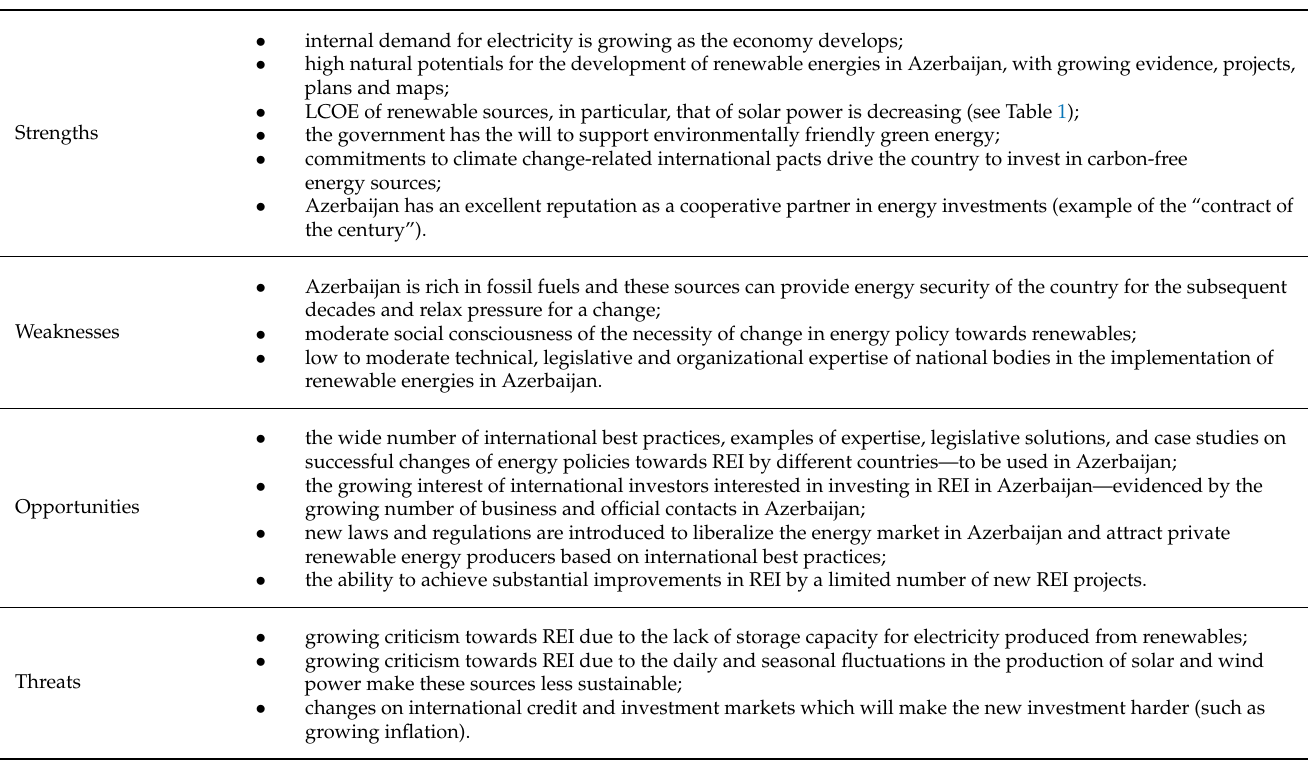
Table 16. SWOT analysis for switching to REI in